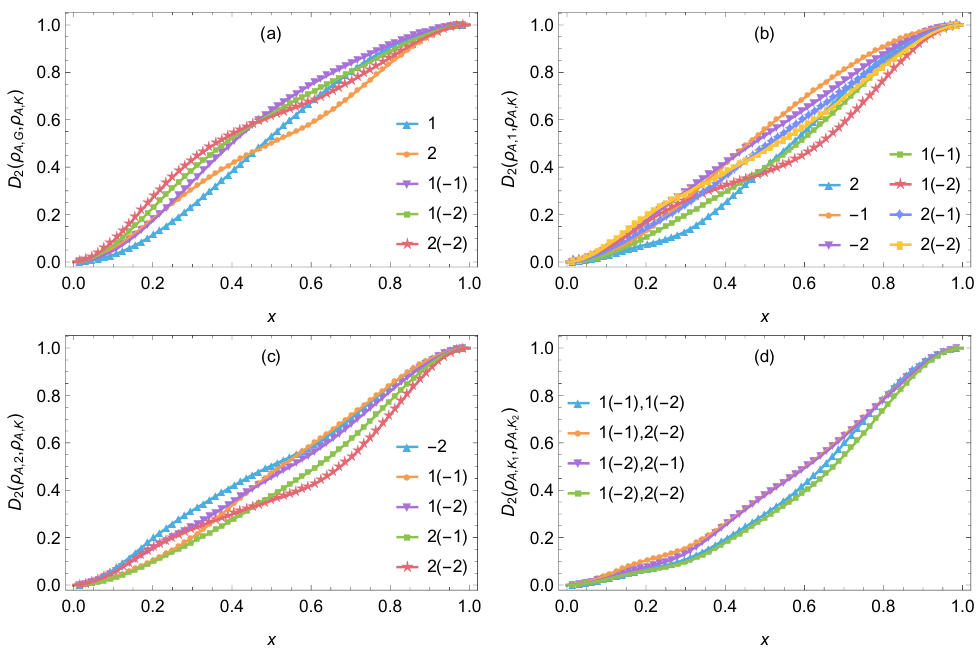
Figure 7 . The second Schatten distance in the 2D free massless non-compact bosonic field theory (lines) and the gapless limit of the harmonic chain (symbols). We have set m = 10 − 5 , L = 64 .